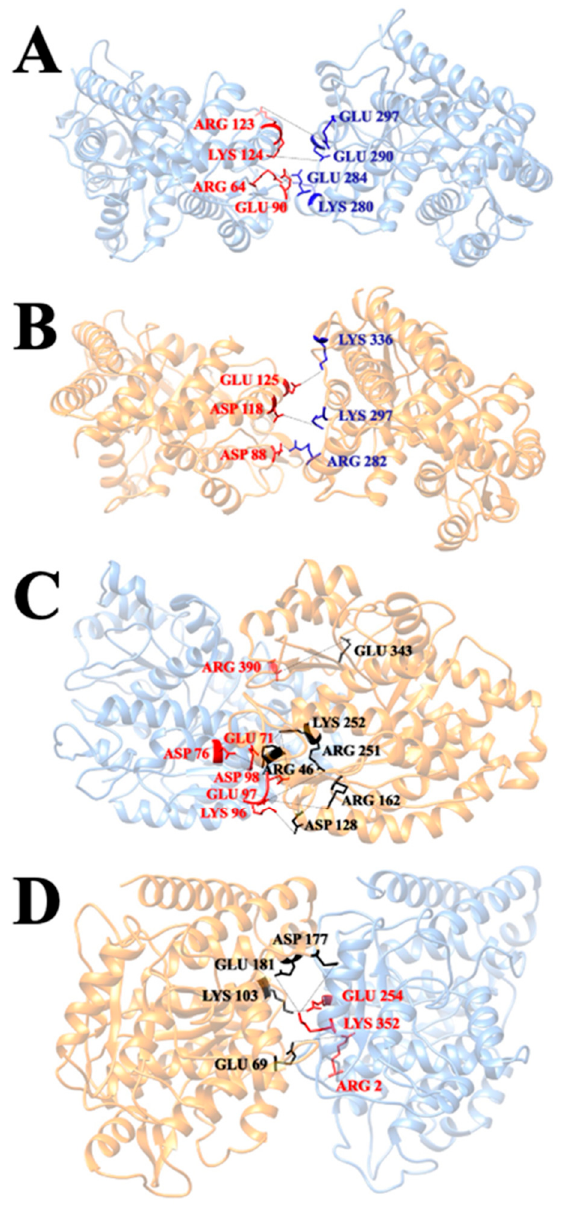
Figure 10. The distribution of salt bridges for α / α , β / β , α / β , and β / α tubulin-tubulin complexes with their occupancies. ( A ) α / α tubulin complex. ( B ) β / β tubulin complex. ( C ) α / β tubulin complex. ( D ) β / α tubulin complex.